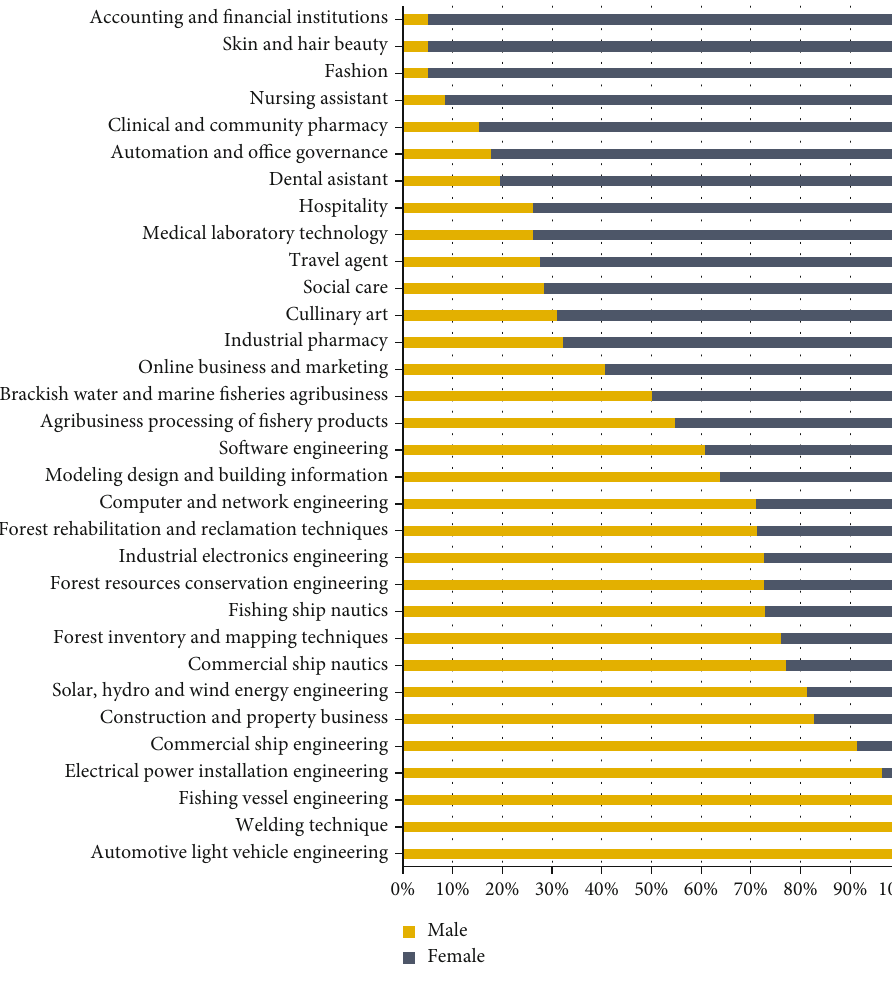
Figure 1: Comparison of the gender distribution of students in various expertise programs at vocational high schools in